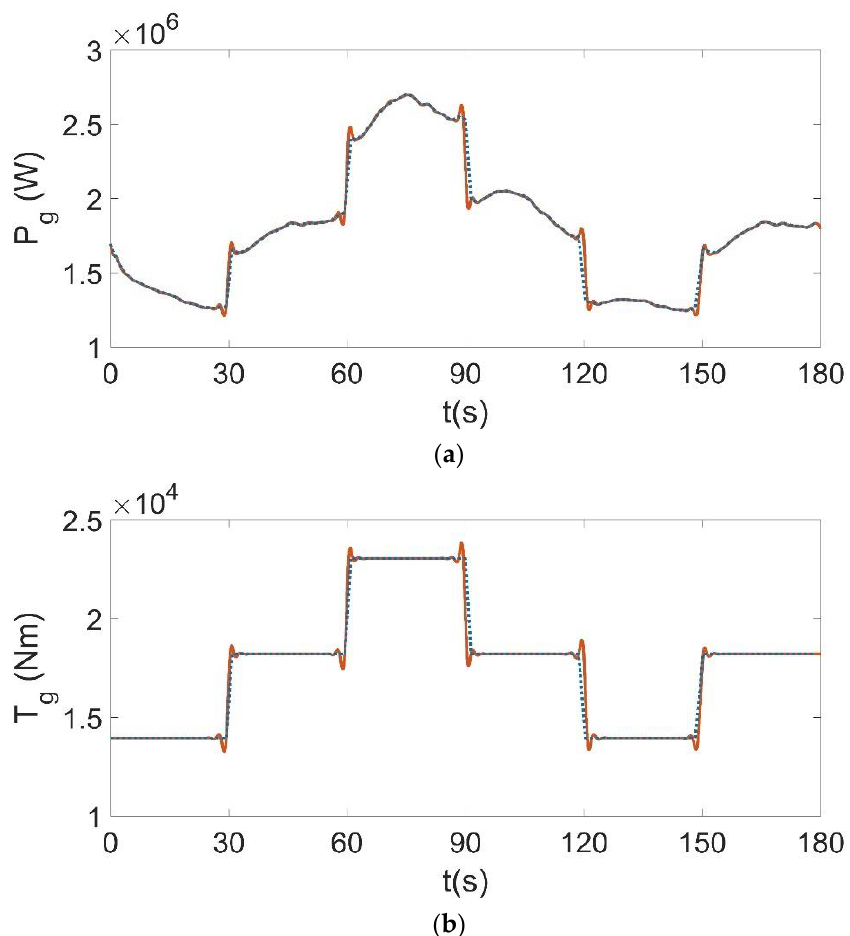
Figure 6. ( a ) Output power P g and ( b ) generator torque T g of WPGS for the robust MPC (red solid line) and stochastic MPC (blue dotted line) in the low wind speed region with small turbu- lence.